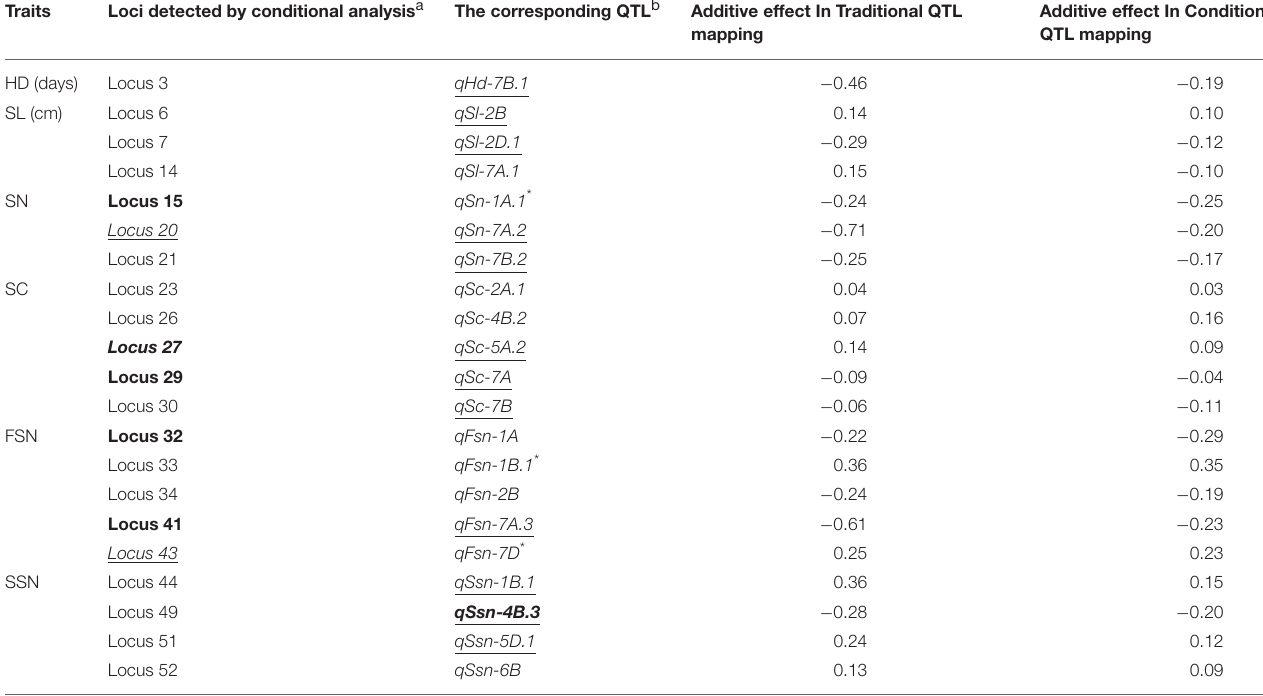
TABLE 2 | The loci for spike characteristics significant using both traditional and conditional QTL mapping. Traits